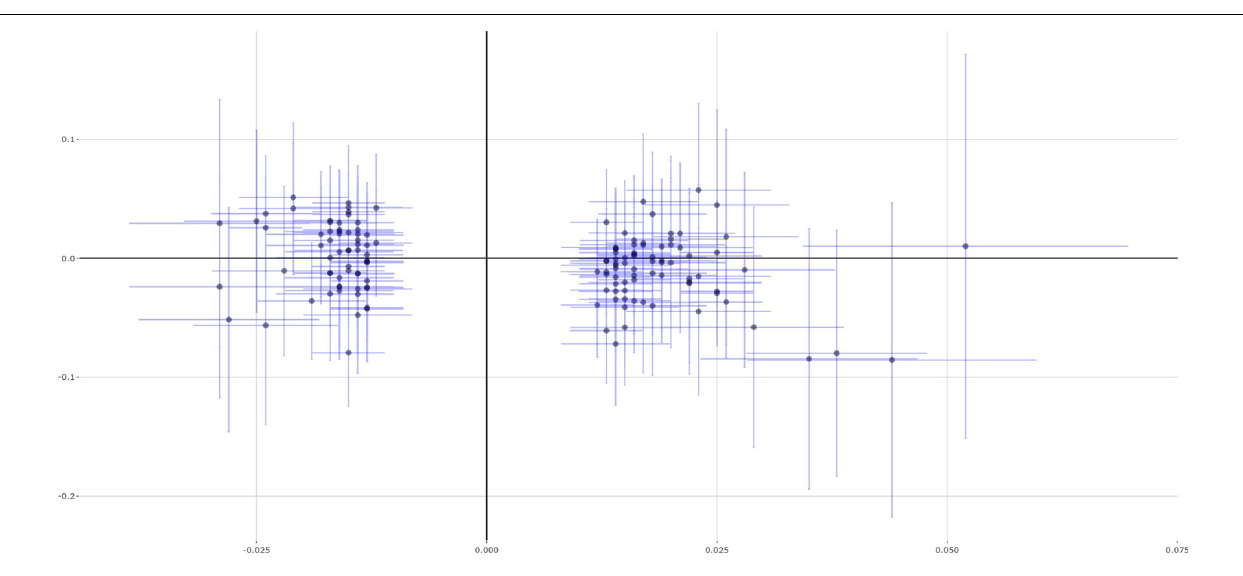
FIGURE 2 | Single estimates about causal association between educational attainment and asthma from MR analysis using weighted median method. This scatter plots represent 141 genetic variants associated with educational attainment on x -axis and risk of asthma on y -axis. Continuous line represents causal effect of educational attainment on risk of